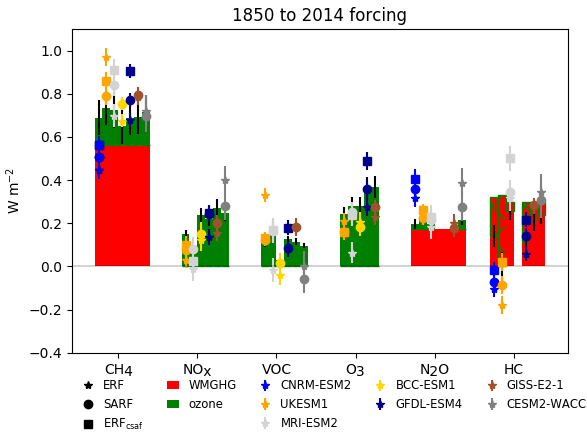
Figure 8. Estimated SARF from the greenhouse gas changes (WMGHGs and ozone), using radiative efficiencies for the WMGHGs and kernel calculations for ozone (see text). Hatched bars show decreases in ozone SARF. Symbols show the modelled ERF, SARF and ERFcs,af (estimate of greenhouse gas clear-sky ERF). Uncertainties on the bars are due to uncertainties in radiative efficiencies. Uncertainties on the symbols are errors in the mean due to interannual variability in the model diagnostic. negative effect ( − 27 ± 9 %) than the sum of NO x and VOC ( − 16 ± 8 %) (uncertainties are multi-model standard devi- ation). This suggests significant non-additivity. Note that a test the additivity